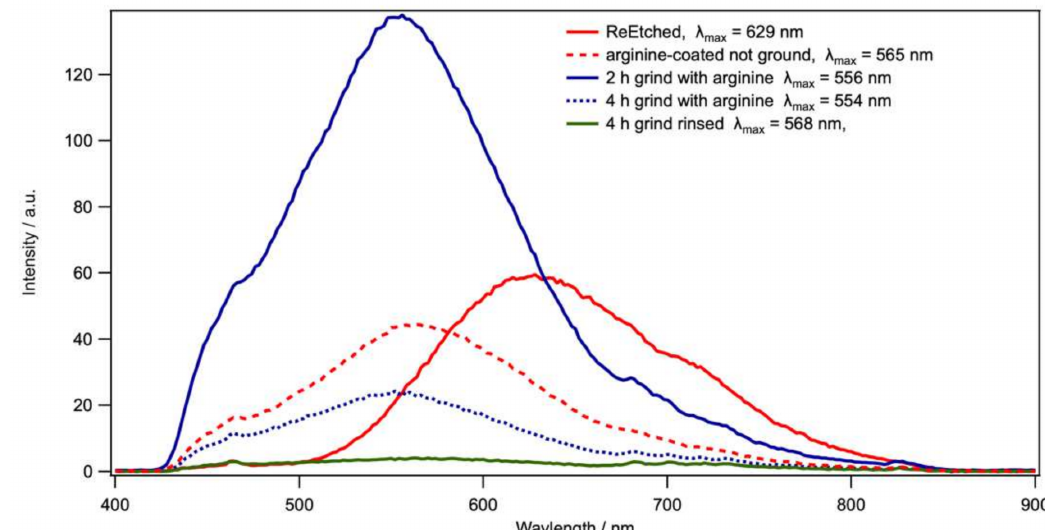
Figure 3. Comparison of the photoluminescence of por-Si powder before grinding (red curves, both as-etched and coated with arginine), por-Si after grinding 2 h or 4 h with arginine (blue curves), and por-Si powder ground with arginine coated with covalently bound arginine, but after rinsing away physisorbed arginine (green